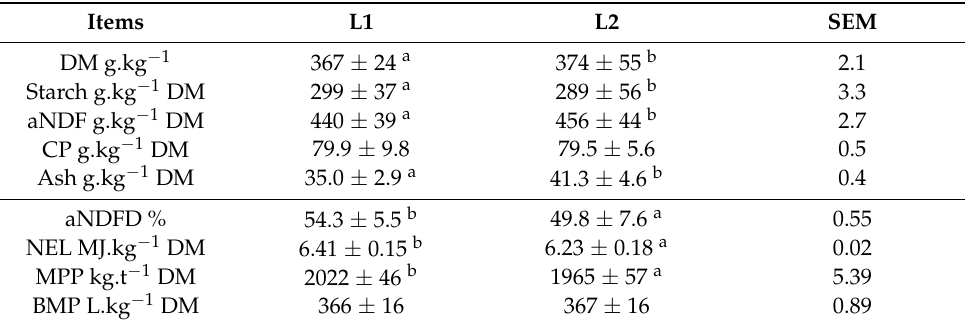
Table 6. Chemical composition and feed value of hybrids by location (L).